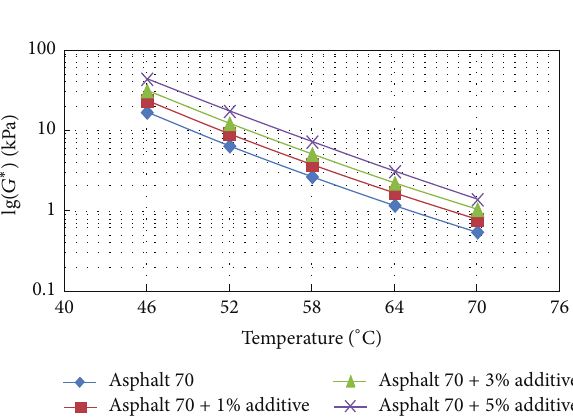
Figure 1: 𝐺 ∗ of 70# virgin asphalt and WMA binder versus temper- ature.